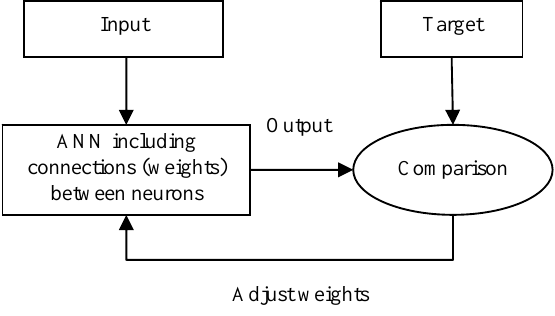
Figure 2 Conceptual operation of ANN